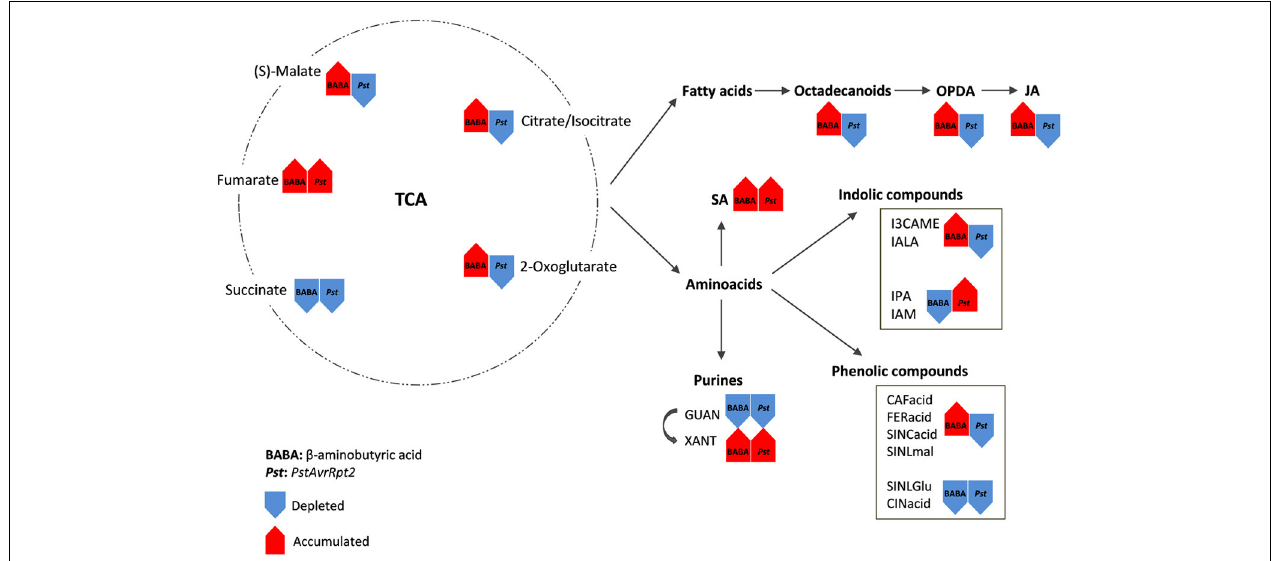
FIGURE 9 | Principal pathways/compounds that show significant changes after the two priming inducers. In priming experiments the stress is usually applied after 48hpt. Rows represent the general changes after this period of time. Red shows the accumulated compounds and blue rows show the depleted compounds/pathways. TCA compounds are the main source for